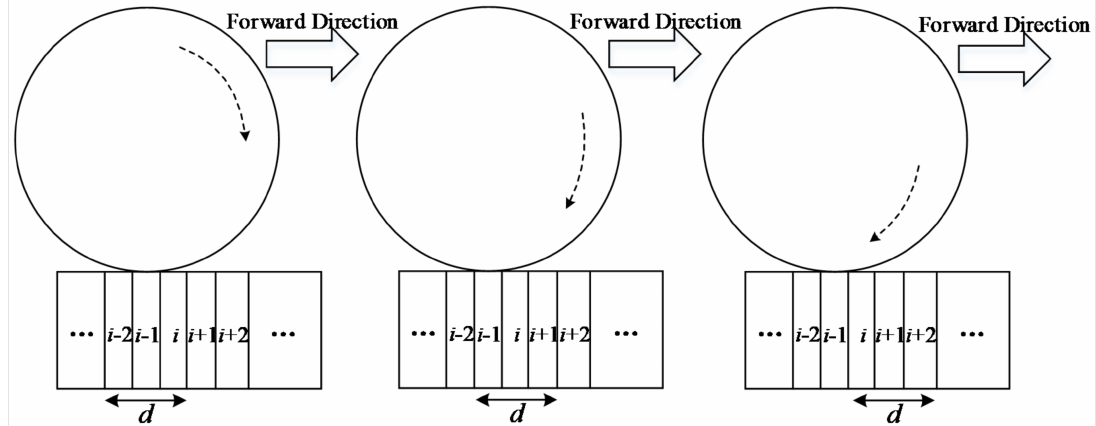
Figure 12. Vibration compaction model considering the walking of the